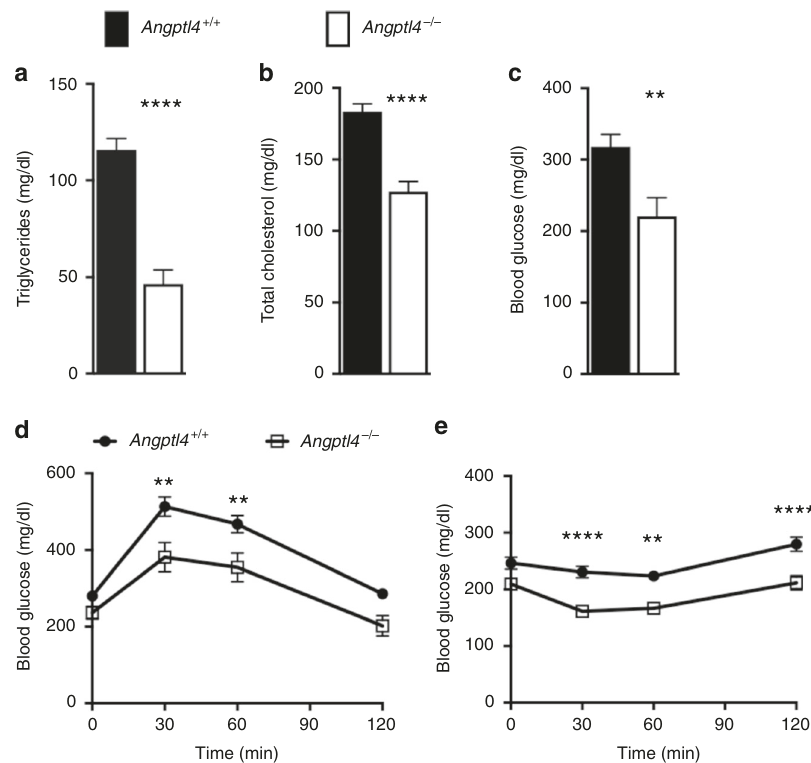
Fig. 4 Angptl4 − / − mice have improved glucose homeostasis. a Serum triglycerides, ( b ) total cholesterol, and ( c ) blood glucose levels in Angptl4 − / − and littermate control mice on a high-fat diet for 9 weeks. d Oral glucose tolerance test and ( e ) insulin tolerance test in the animals described in ( a – c ). All groups had 9 – 11 animals. Values are mean ± SEM. Statistical analysis by Welch ’ s t-test ( a ) and 2-way ANOVA with Sidak ’ s post-test ( d , e ), ** p < 0.001, **** p < 0.0001. The study was conducted in three different cohorts of mice, with qualitatively similar results in each